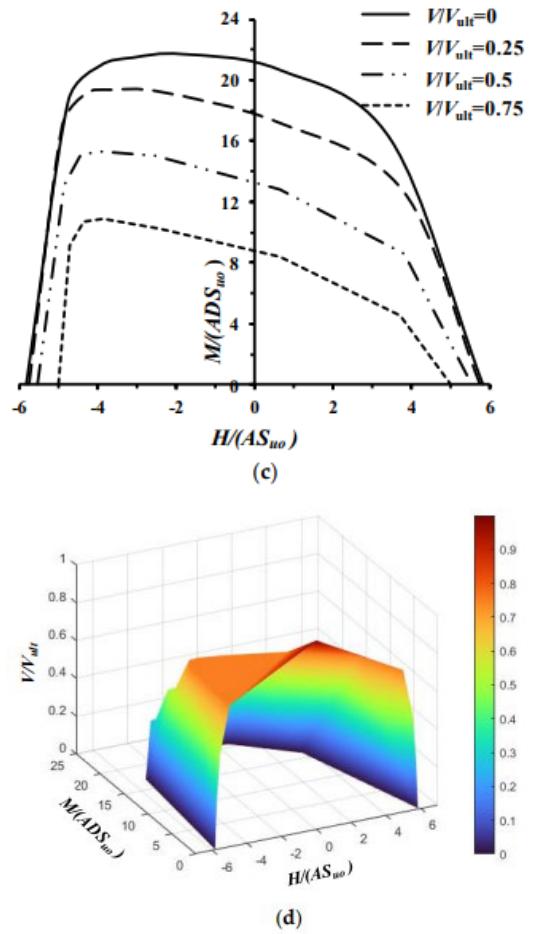
Figure 17. Dimensionless V − H − M capacity envelopes under different S / D ratios: ( a ) S / D = 1(2D); ( b ) S / D = 1(3D); ( c ) S / D = 3(2D); and ( d ) S / D = 3(3D).